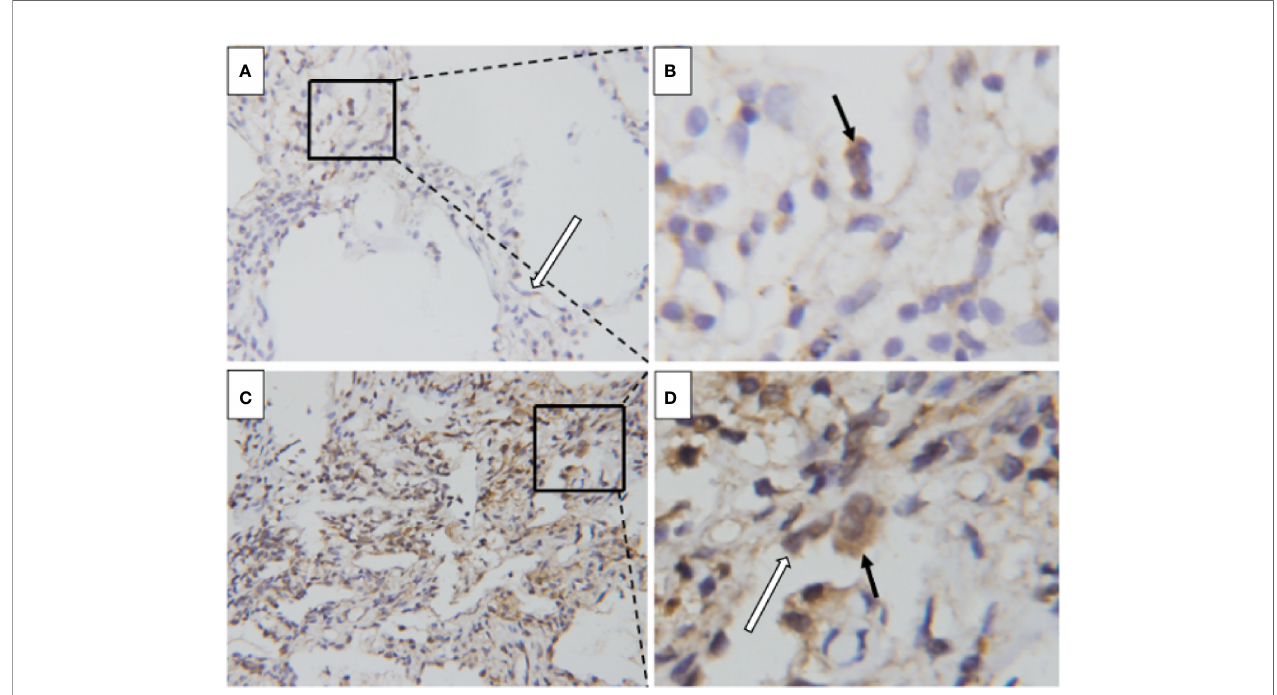
FIGURE 4 | Enhanced adrenomedullin expression in the lung tissue of DM patients with RP-ILD. (A, B) The lung of a DM patient with chronic ILD. Positive adrenomedullin staining was detected in macrophages (black arrowhead) and alveolar epithelial cells (white arrowhead). (C, D) The lung of a DM patient with RP-ILD. Positive adrenomedullin staining was detected in macrophages (black arrowhead) and alveolar epithelial cells (white arrowhead). Scale bar = 50 m m. DM, dermatomyositis; ILD, interstitial lung disease; RP-ILD, rapidly progressive